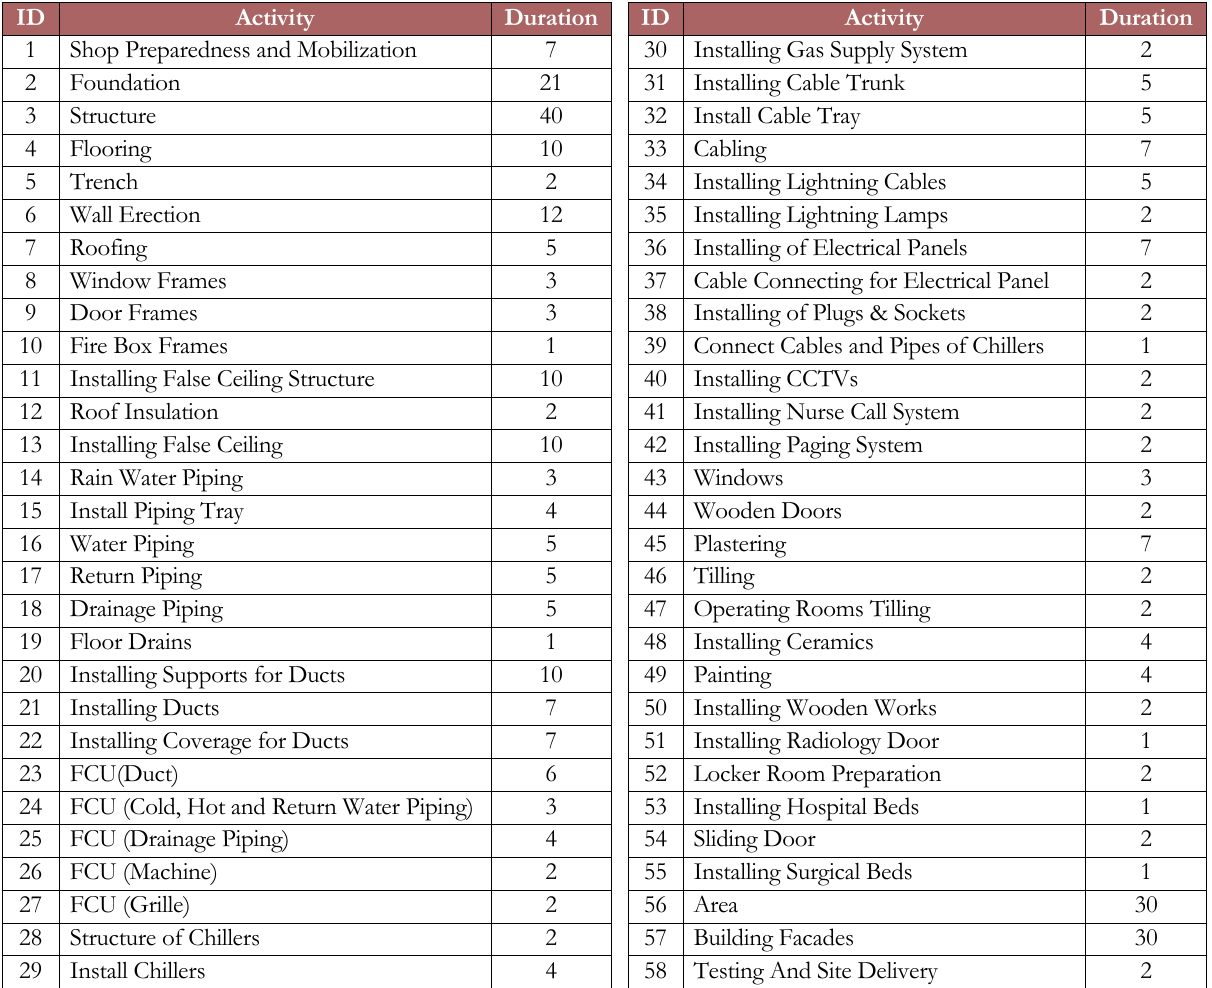
Table 5. List of Activities for Constructing a